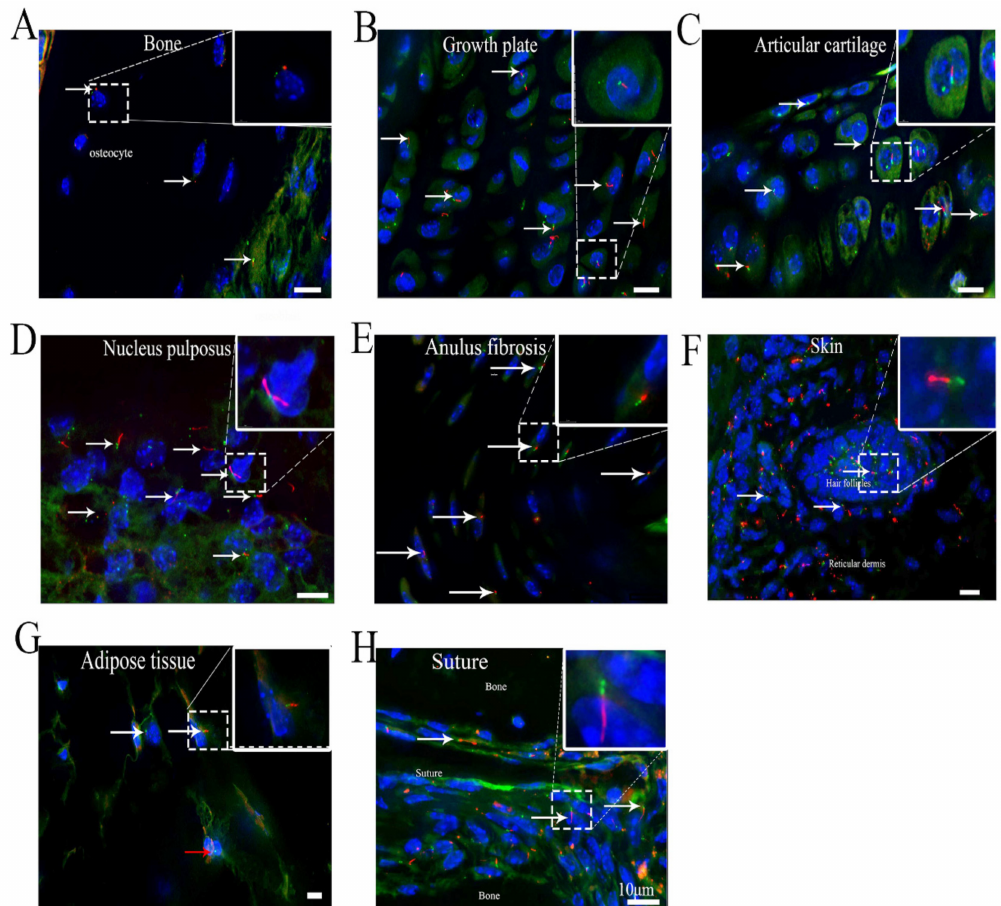
Figure 5. Cilia are present in different organs in the musculoskeletal system. ( A ) Bone tissue from femur, ( B ) growth plate from tibia, ( C ) articular cartilage, ( D ) NP in intervertebral disc, ( E ) AF in intervertebral disc, ( F ) skin, ( G ) adipose tissue, and ( H ) suture. White arrow, cilium with an axoneme and basal body. Yellow arrow, localization of ARL13B. Red arrow, cell with only Centrin2. Green, Centrin2-GFP. Red, ARL13B-mCherry. Blue, DAPI. Scale bar, 10 µ